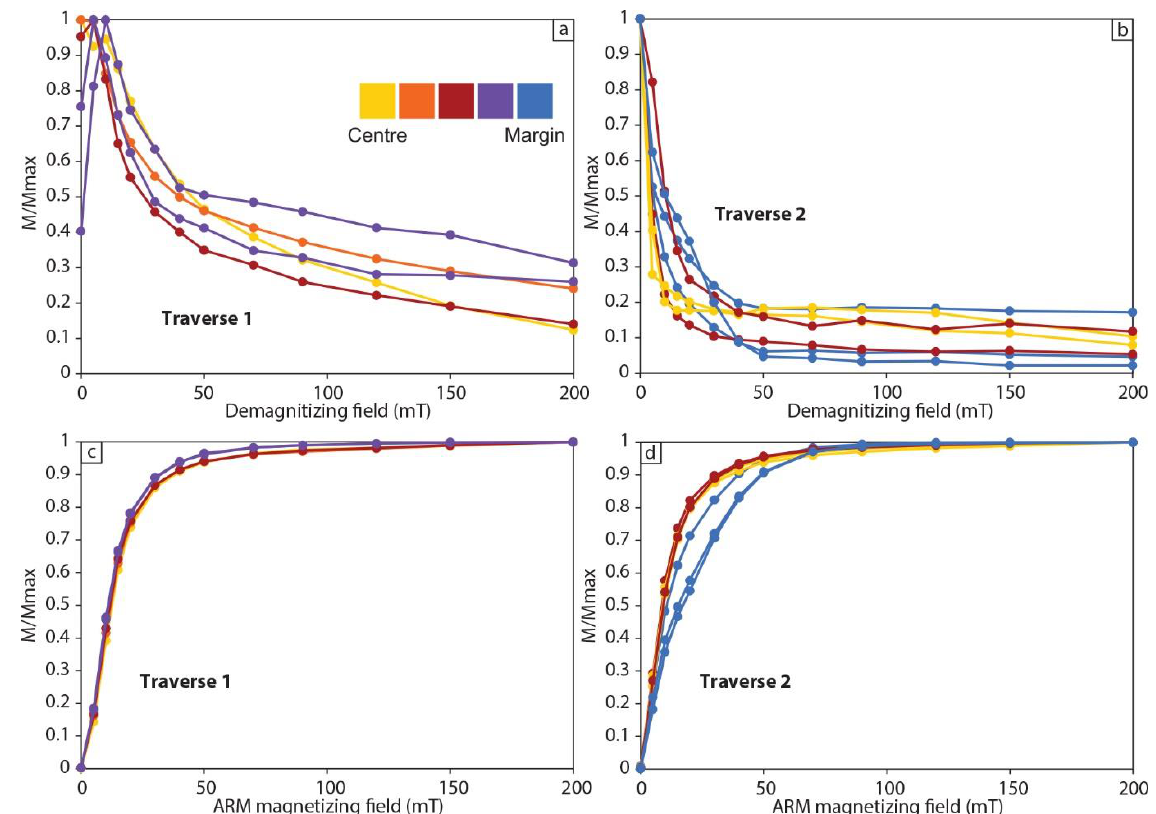
Figure A4. NRM ( a ) and ( b ) and ARM ( c ) and ( d ) magnetization plots. The samples stepwise demagnetised along 3-axes (x+, y+, z+) to a maximum AC field of 200 mT. During ARM magnetization, the selected specimens were imparted with a stepwise increasing AC field and constant DC field of 500 µT along the specimen z+ axis to maximum AC field of 200 mT.